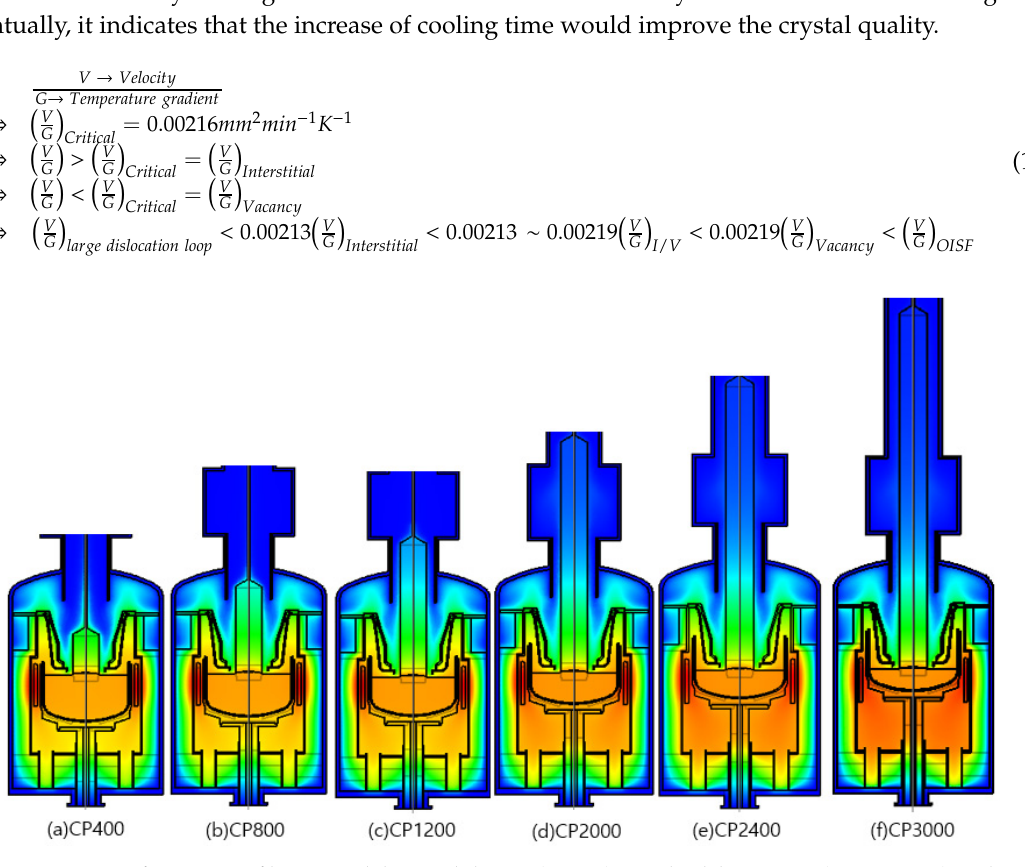
Figure 2. Configuration of basic model crystal design (BTCD) Czochralski process (CZ-process) with different CP (crystal position) 400, 800, 1200, 2000, 2400, and 3000 mm based at a 1.0 mm/min pulling rate.